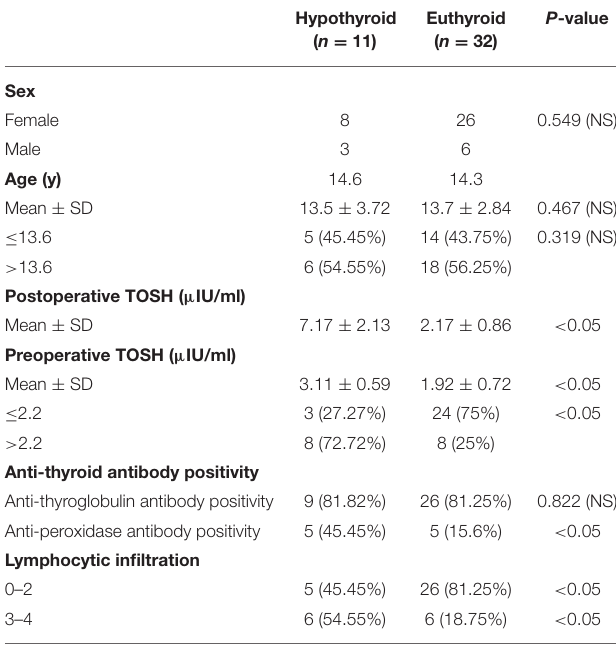
TABLE 1 | Association between clinicopathological characteristics and development of hypothyroidism after